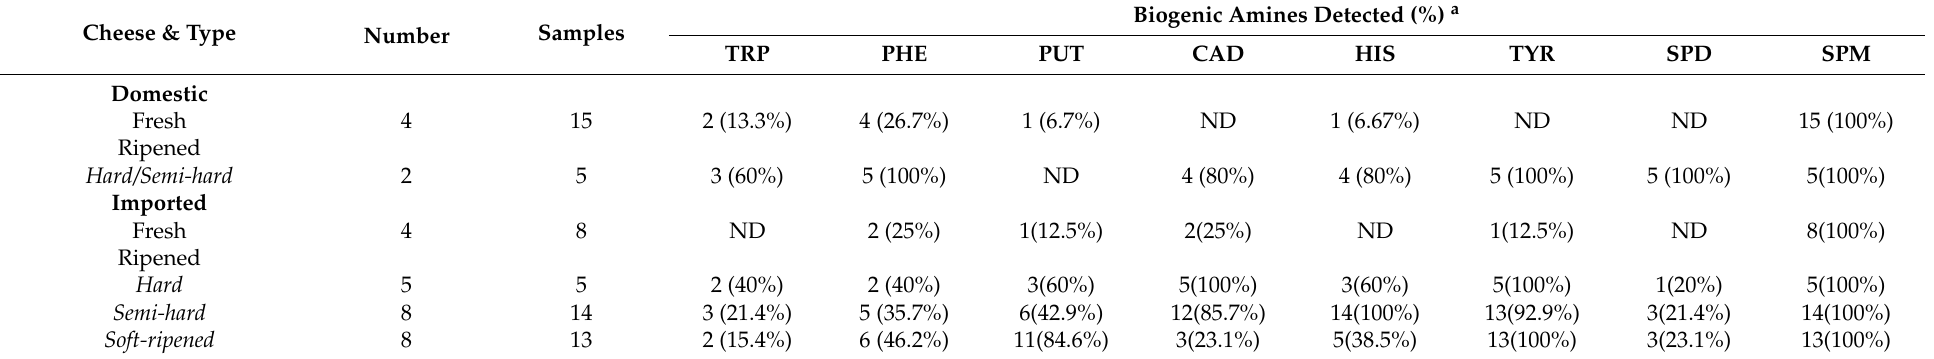
Table 2. Distribution of biogenic amines (mg/kg) in cheeses from the farmstead and retails markets in the Republic of Korea.